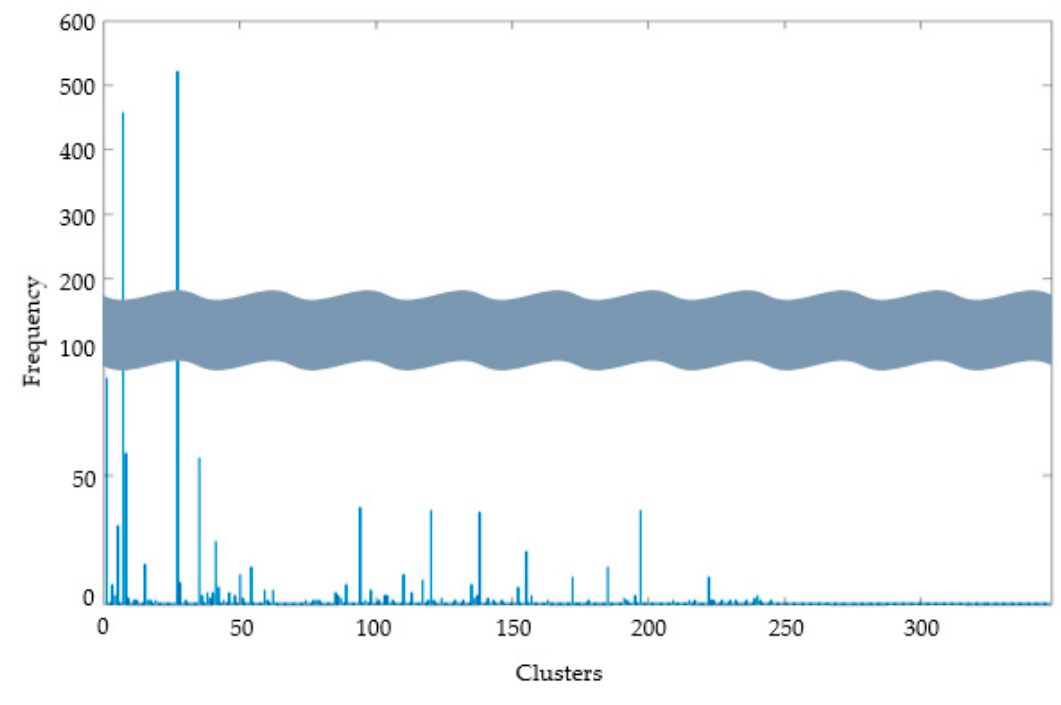
Figure 12. Frequency of clusters.